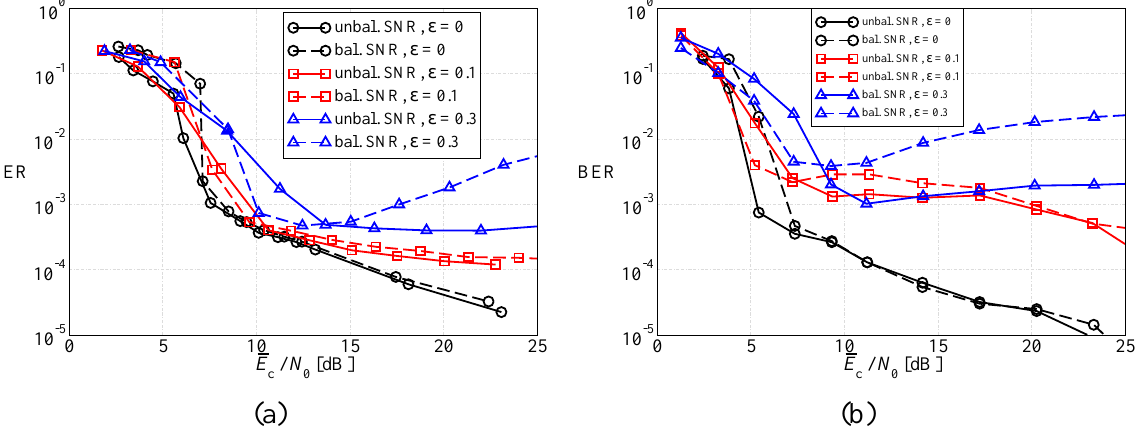
Figure 9. Average BER, as a function of the average SNR at the sources, in a scenario with non-orthogonal links, considering: (a) DD LDPC-coded schemes and (b) SCCCed schemes. Two possible values for ǫ are considered: (i) 0.1 and (ii)